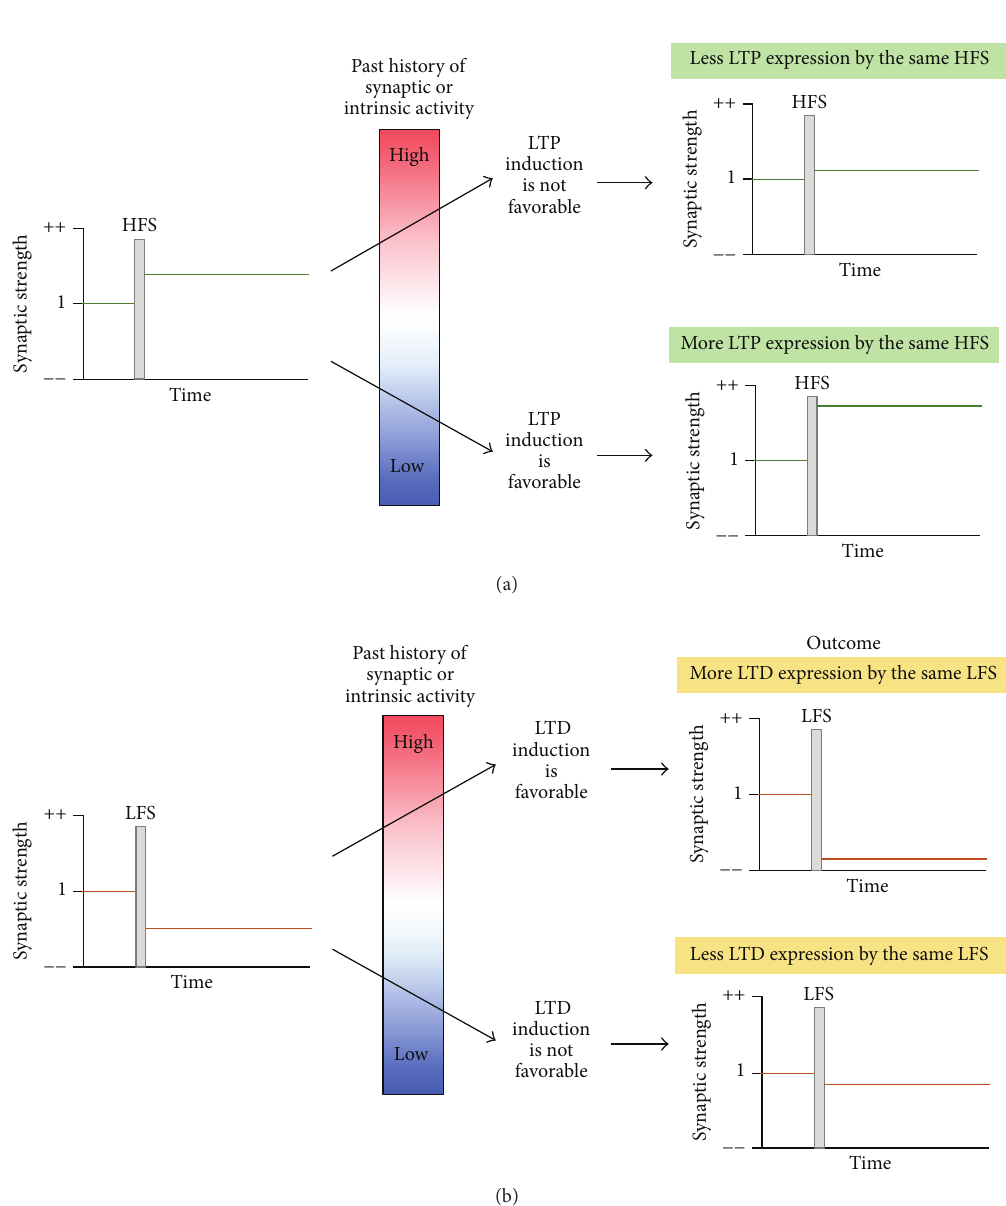
Figure 1: Metaplasticity. The induction threshold of LTP and LTD can be modified as a consequence of overall past synaptic or intrinsic activity of postsynaptic neurons. Such compensatory adjustment called “metaplasticity” provides stability to neuronal networks that support Hebbian synaptic plasticity. (a) LTP induction by conventional high frequency stimulation (HFS) is favorable in the neurons whose previous synaptic and intrinsic activities were low. (b) LTD induction by conventional low frequency stimulation (LFS) is favorable in the neurons whose previous synaptic and intrinsic activities were